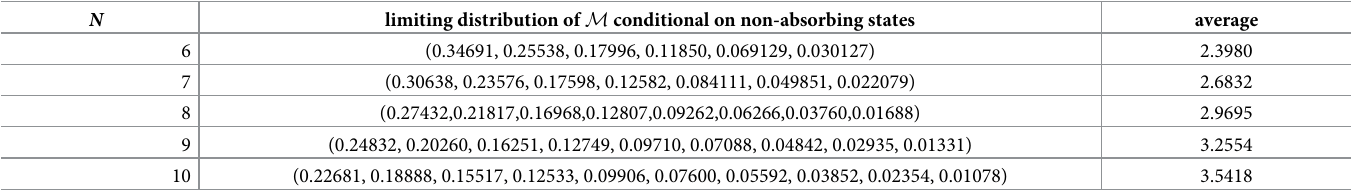
Table 1. The limiting distribution of M on viable cells and average number of chromosome copies, for 6 (cid:20) N (cid:20) 10. The i th entry of each vector is the limiting fraction of viable cells with i copies of the chromosome. N